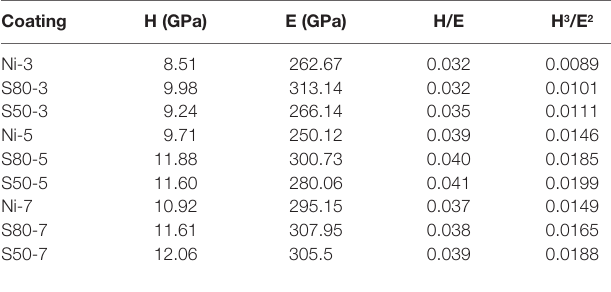
TaBle 4 | Mechanical properties of nanocomposite coatings. coating